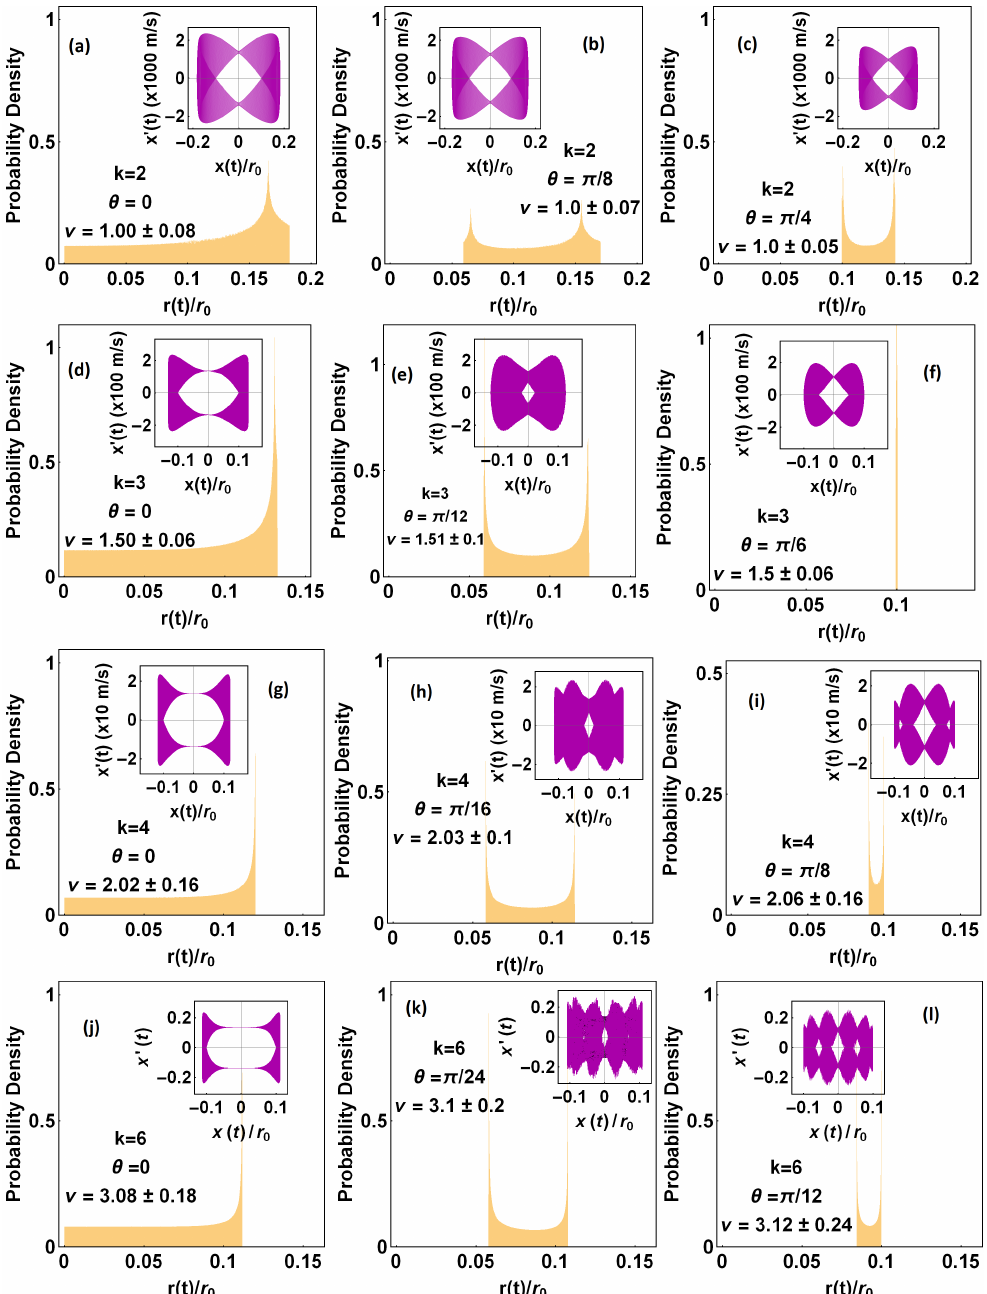
Figure 4. We show the probability distribution for the radial position coordinate, r, in different traps for a stationary ion which is created at t = 0, with initial position of radius r ( 0 ) = 0.1 r 0 and azhimuth angle θ ; we also show the corresponding phase space trajectories in the insets. Our results reveal that all higher order pole traps differ from quadrupole traps in some ways. Trap dynamics with these realistic initial conditions have not been studied earlier explicitly. The results in panels ( a – c ) for quadrupole trap, show that, change in θ does not effect the form of phase space density. This is in accordance with the other studies where the ion is created at r ( 0 ) = 0 with non-zero velocities. However, our results for higher order traps in panels ( d – l ), unveil completely different behavior of ion motion in practical higher pole traps. Not only are the position distributions unique with characteristic sharp cut offs at r = r ( 0 ) , but the nature of the phase space trajectory shown in the insets, also varies significantly with θ . This is important to be factored in when working with higher pole traps while evaluating ensemble average